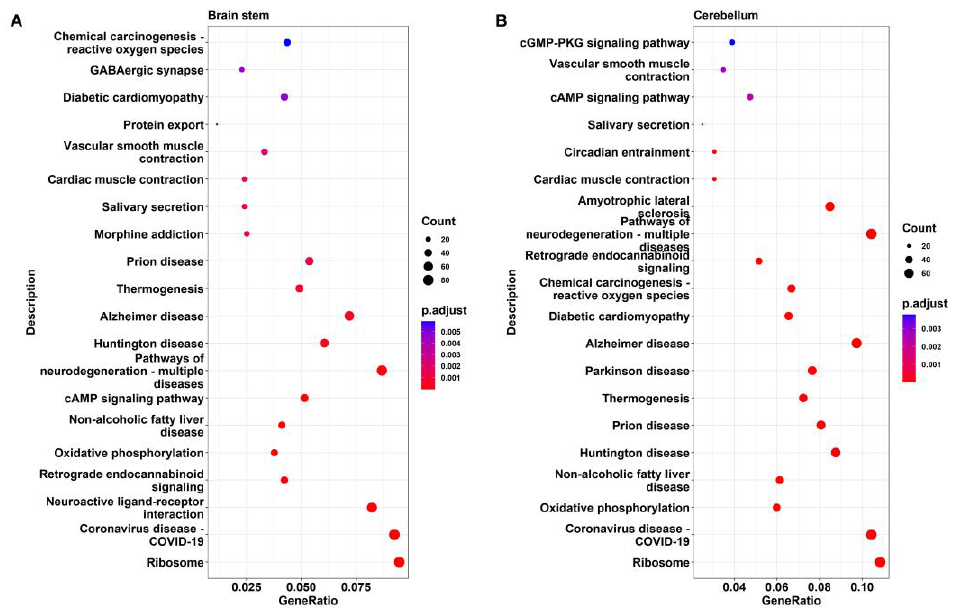
Figure 7. KEGG pathway analysis of the DEGs in the brain stem ( A ) and cerebellum ( B ) of male DAPK1-KO mice.